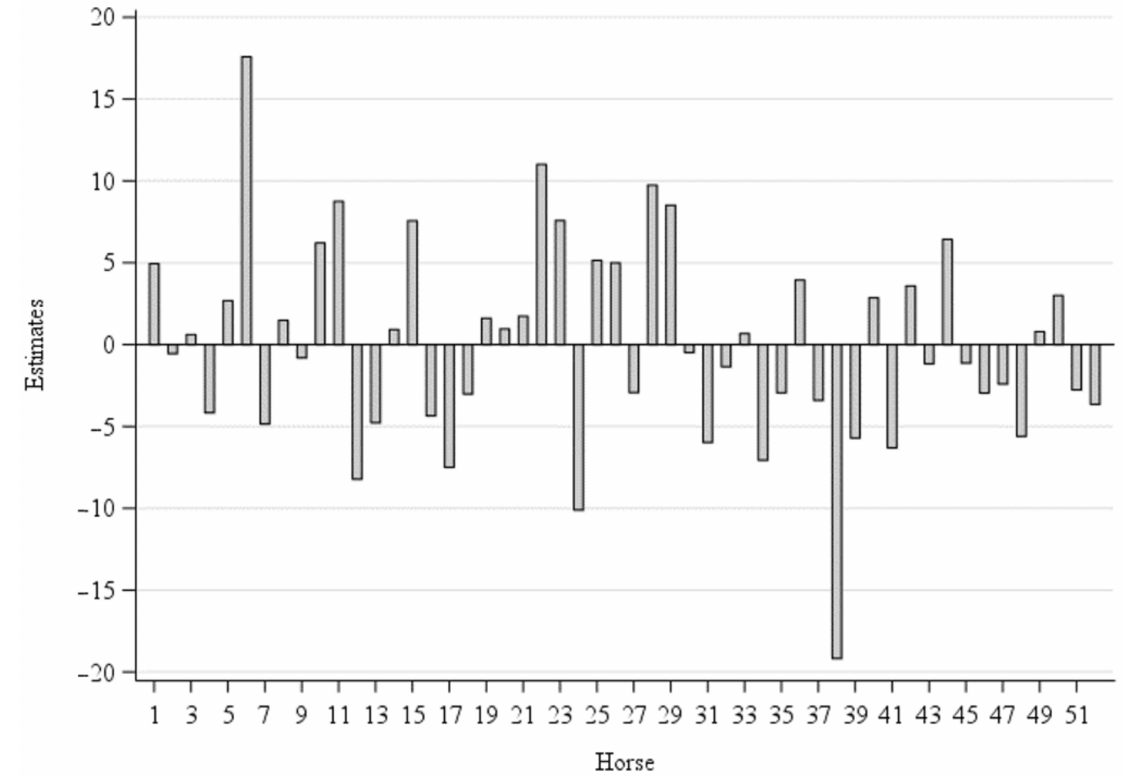
Figure 4. Estimates (Squares visited per hour) of the random effect